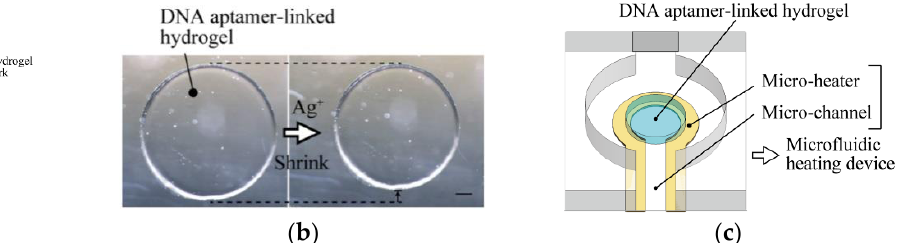
Figure 33. ( a ) The structure of Ag-DNA aptamer reversibly changes through binding and dissociating the silver ions ( b ) The volume change of the DNA aptamer-linked hydrogel as the sensor response toward 10 mM Ag + ions. The scale bar is 500 μm ( c ) Scheme of the DNA aptamer-linked hydrogel sensor integrated with the microfluidic heating device for repeatable detection of chemical substances [120].